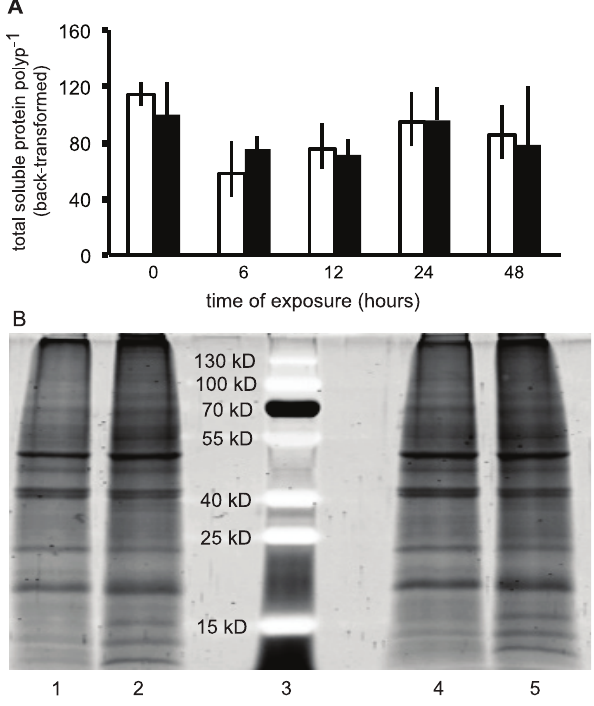
Figure 6. Total holobiont soluble protein per polyp and a representative SDS-PAGE gel from the thermal stress experi- ment. (A) Proteins were extracted from the same samples from which RNA and DNA were isolated, and error bars represent standard error of the back-transformed mean for both control (white columns) and experimental (black columns) samples. (B) A representative SDS-PAGE gel (20 m g protein) from two randomly chosen samples from both the control (lanes 1–2, representing samples from time= 0 and 6, respectively) and elevated temperature (lanes 4–5, representing samples from t=0 and 6, respectively) treatments. A pre-stained protein ladder (lane 3) is also depicted.